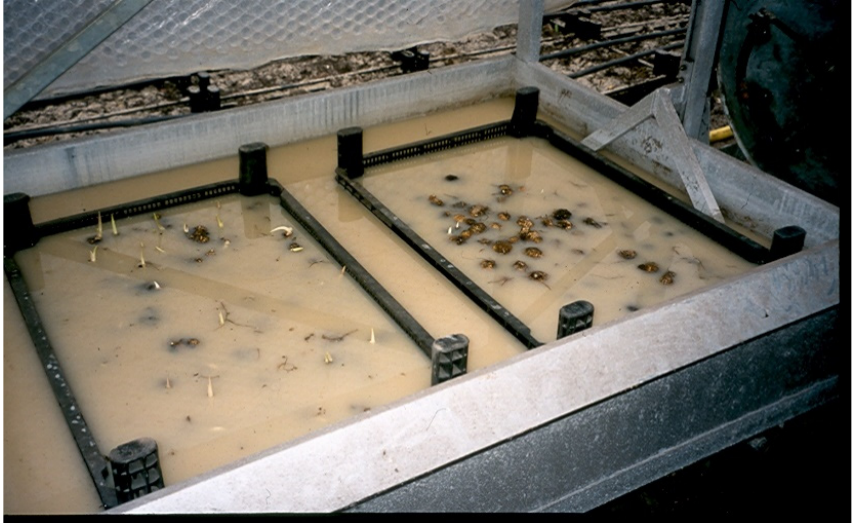
Figure 4. Rhizomes soaking in water solution of growth regulators (Beata Janowska